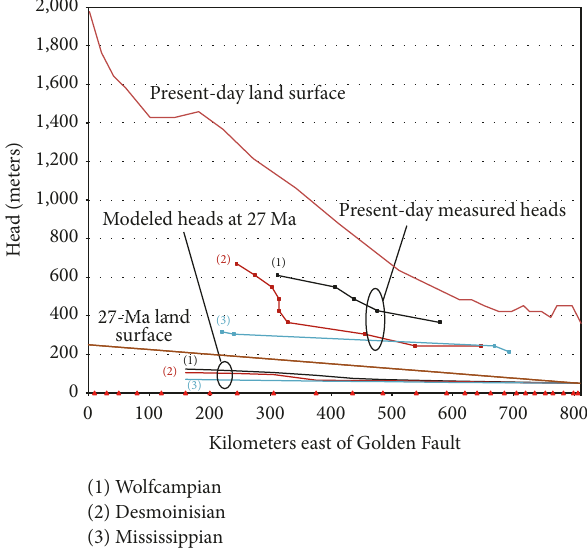
Figure 28: Modeled head results of running the first model, the 27 Mamodelrepresentingthe13-million-yearperiodfrom40to27Ma, compared to present-day heads. Model curves (1) , (2) , and (3) (Wolfcampian, Desmoinesian, and Mississippian, resp.) eventually approach the present-day data curves. Red triangles at centroids of the grid columns mark the initial zero heads at 70